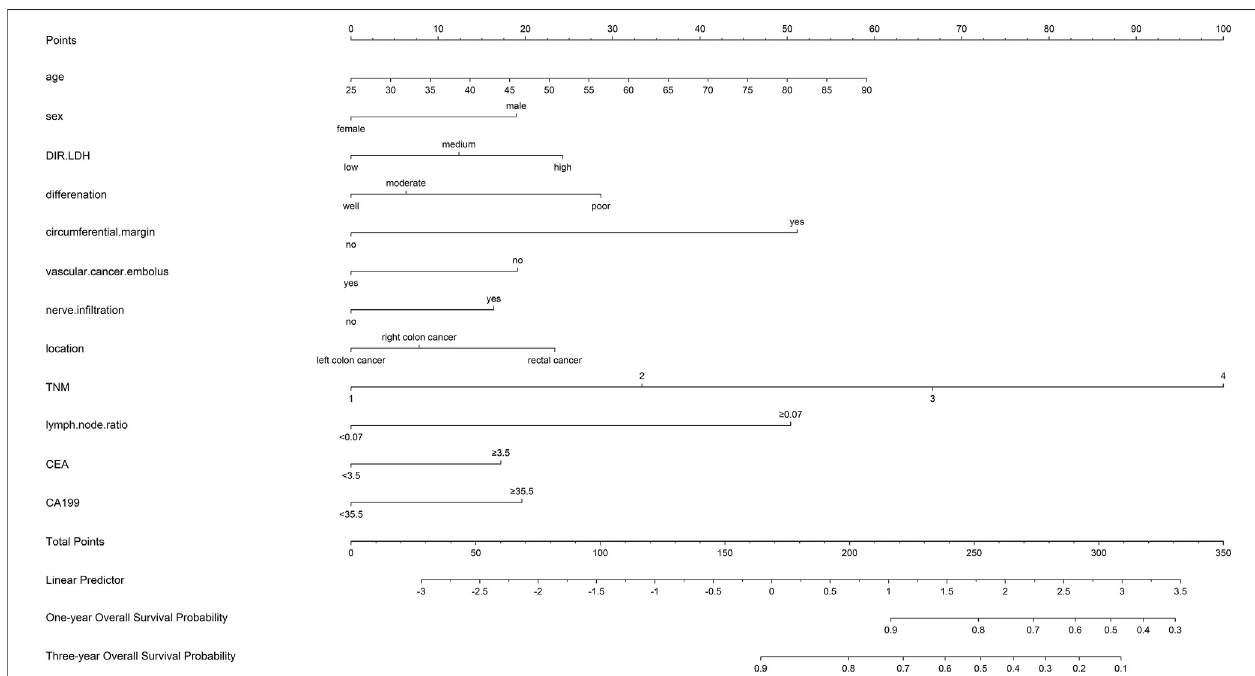
FIGURE 4 | Nomogram of the prognostic model for the OS of patients with colorectal cancer.